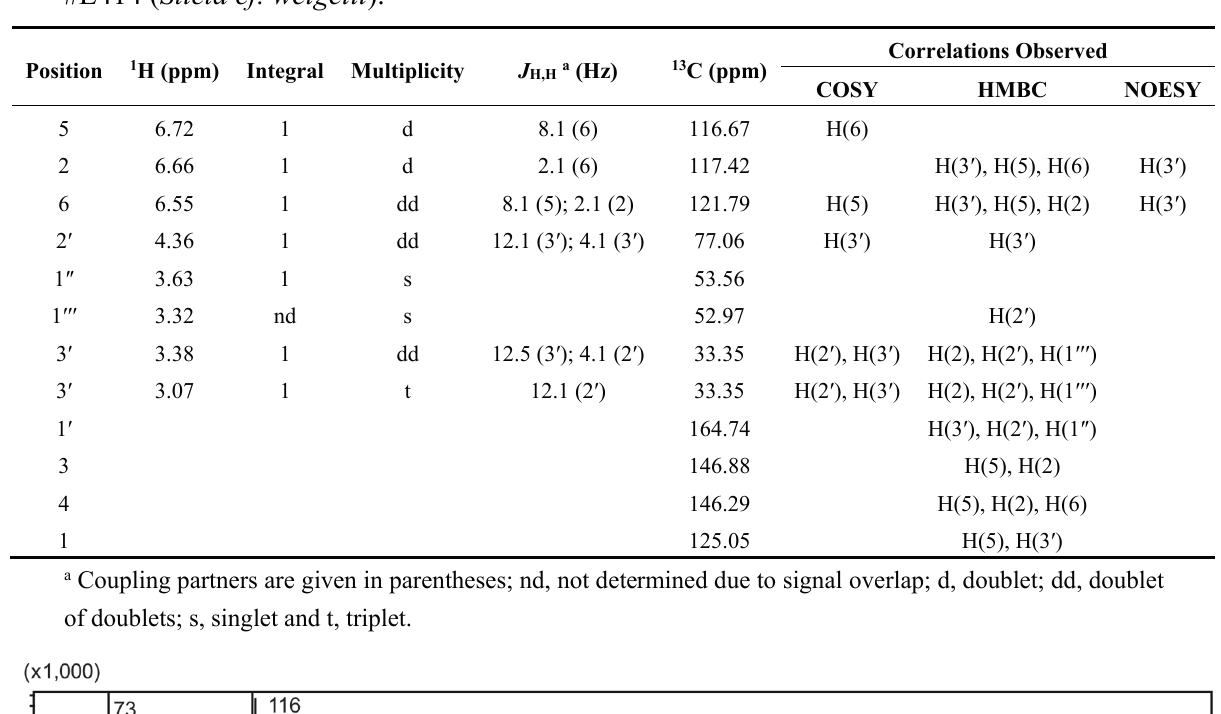
Table 1. NMR data of sticticin on the basis of the detected signals using the crude extract of #E414 ( Sticta cf. weigelii ).